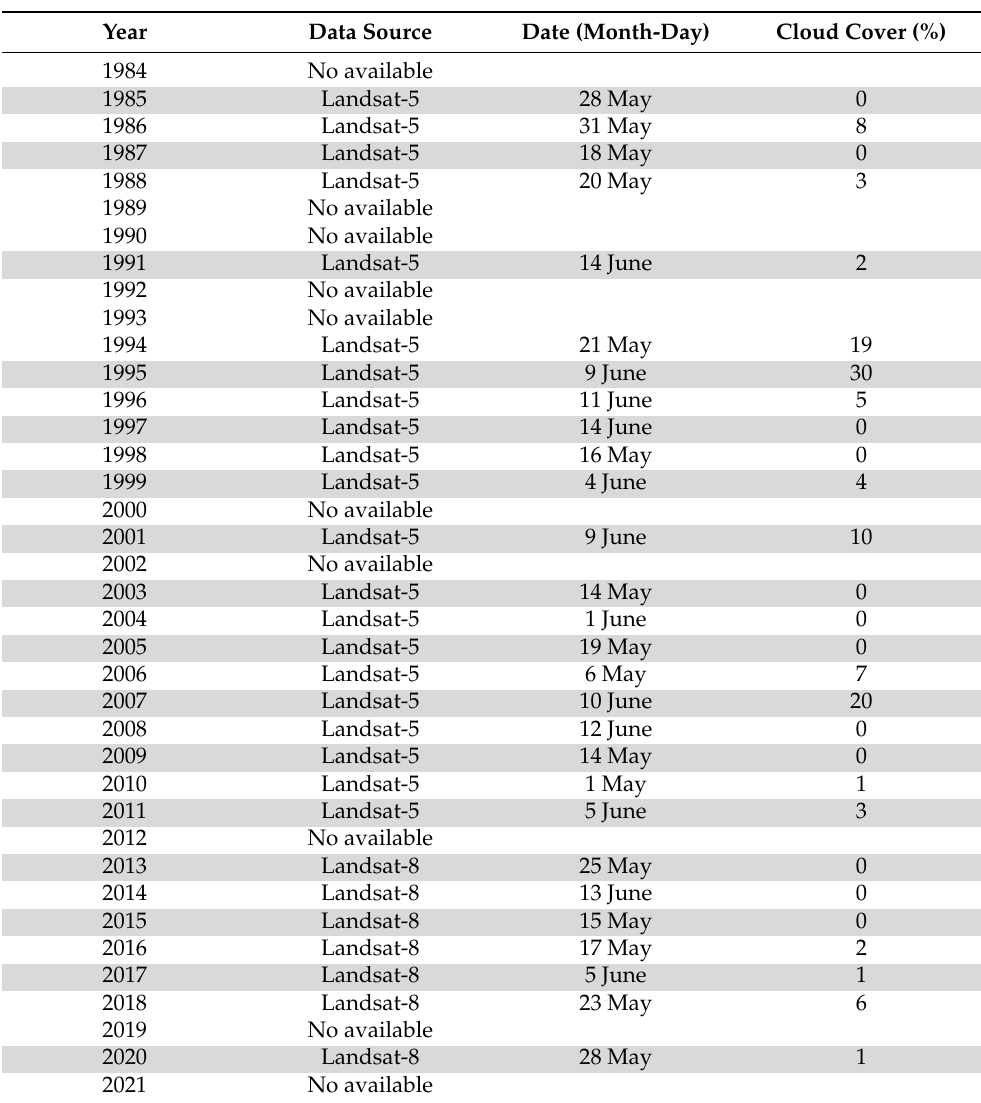
Table 1. The available data from Landsat image series in the study